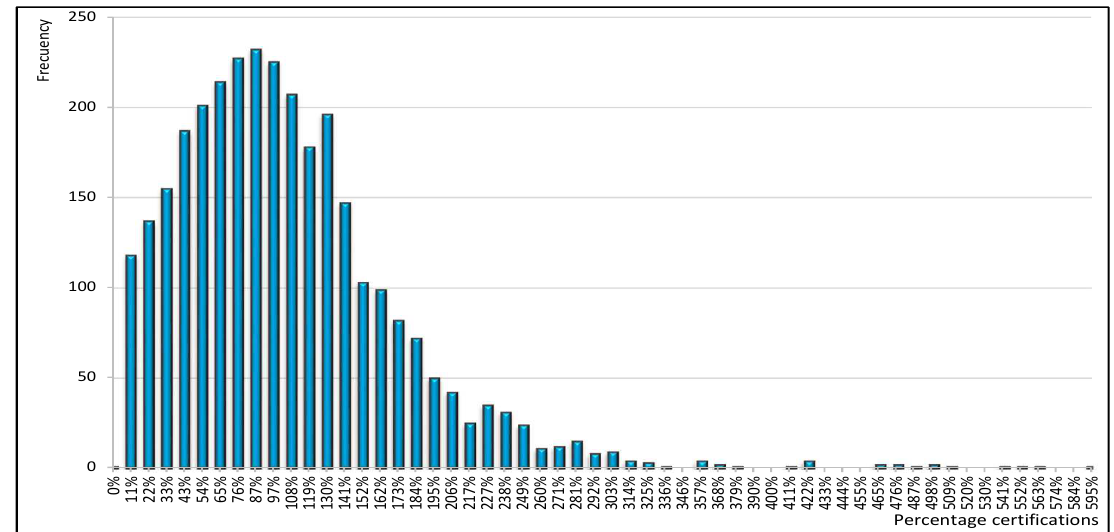
Fig. 1 Frequency histogram for percentage certifications. Source: own